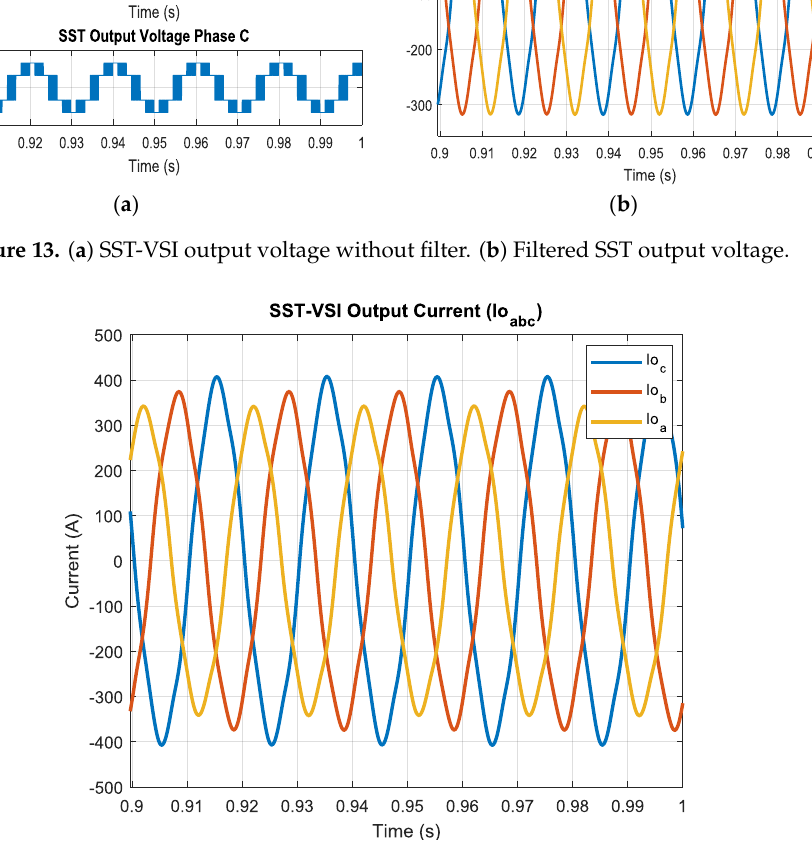
Figure 14. SST output current to the unbalanced load. Appl. Sci. 2019 , 9 , x FOR PEER REVIEW